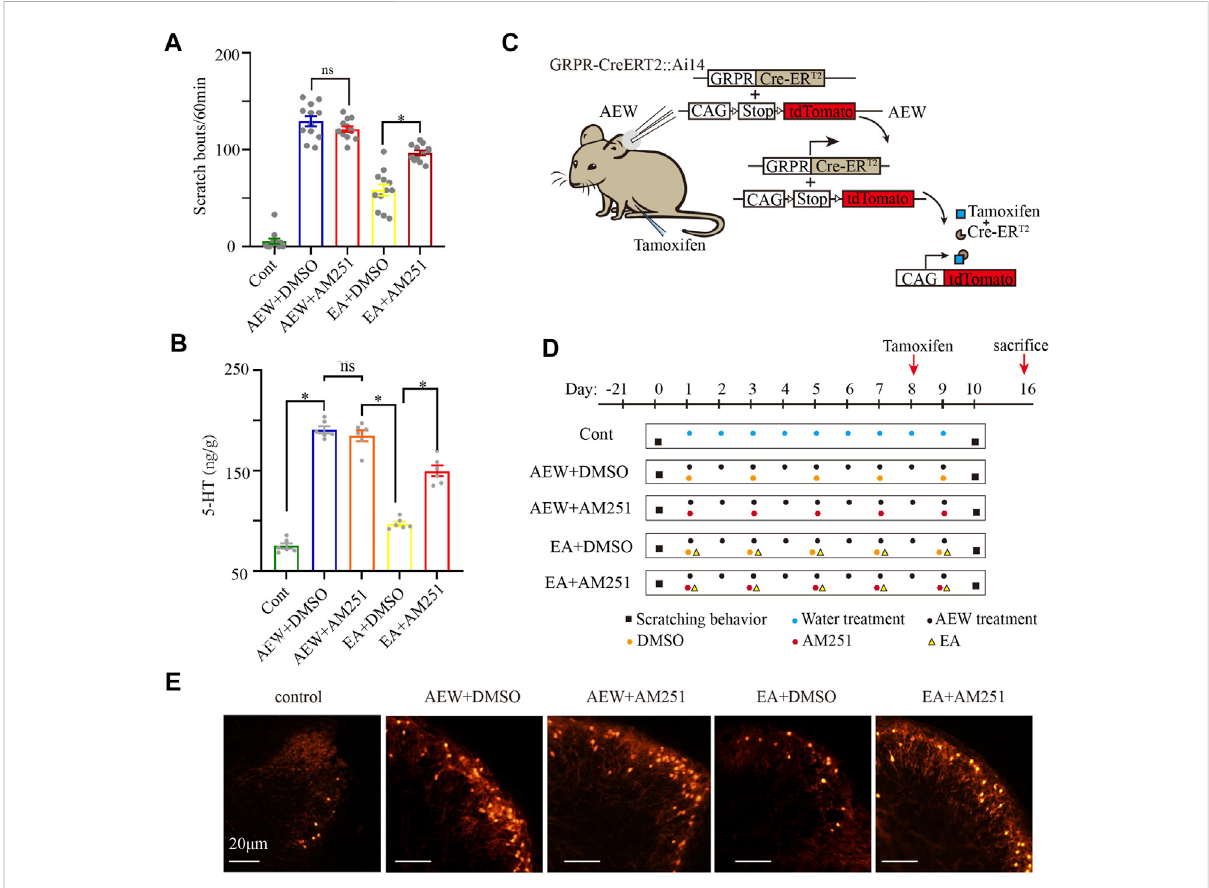
FIGURE 3 AM251 reverses the antipruritic effect of EA on AEW mice via CB1 receptors. (A) The scratch bouts in control, AEW+DMSO, AEW+AM251, EA+DMSO and EA+AM251 groups. (B) The 5-HT concentration in the medulla oblongata in control, AEW+DMSO, AEW+AM251, EA+DMSO and EA+AM251 groups. (C,D) Experimental strategy for AM251 inhibiting the effect of EA on GRPR. (E) GRPR expression in the cervical cord in control, AEW+DMSO,AEW+AM251,EA+DMSOandEA+AM251groups.Scalebar,20 μ m.Dataareexpressedasmeans±SEM( n =12miceineachgroup in A, n = 6 samples in each group in (B) . * p <